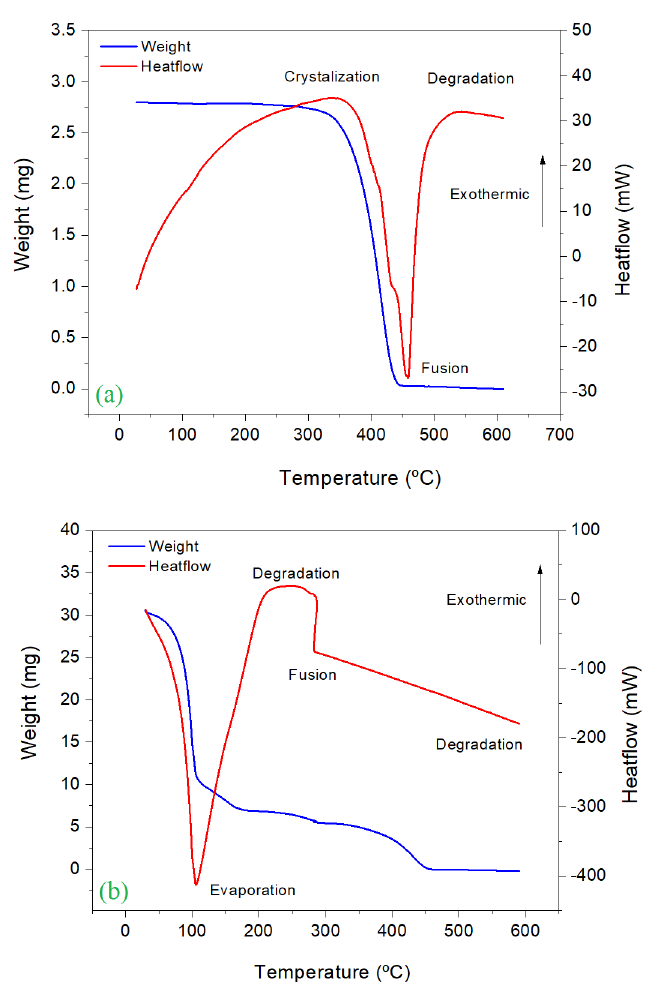
Figure 5. Thermogravimetric analysis of PVC before ( a ) and after ( b ) the adsorption process. Approximately 98.3% of PVC is degraded in the temperature interval of 250 ◦ C–445 ◦ C.